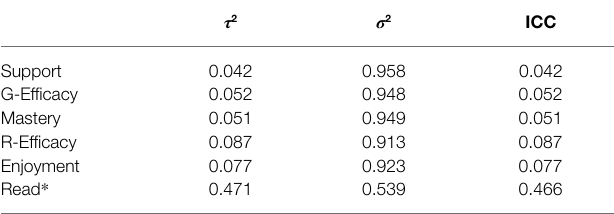
TABLE 2 | Variance components and intraclass correlation